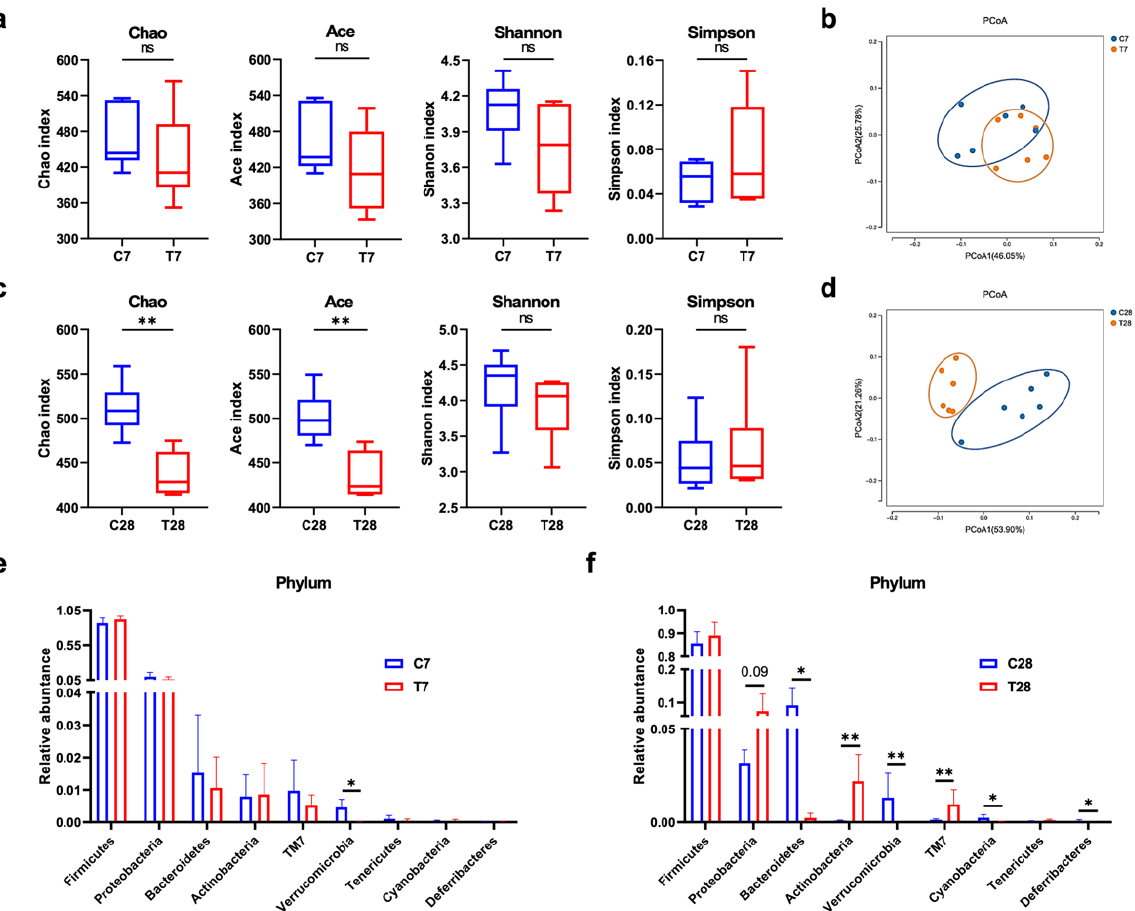
Figure 8. Compositional change of gut microbiota post-TBI. The α -diversity of the gut microbiota at 7 days ( a ) and 28 days ( b ) post-TBI ( n = 6 per group). PCoA of the gut microbiota composition with weighted UniFrac distance at 7 days ( c ) and 28 days ( d ) post-TBI ( n = 6 per group). Relative abundance of gut microbiota at the phylum level at 7 days ( e ) and 28 days ( f ) post-TBI ( n = 6 per group). Data are shown as median with range. * p < 0.05, ** p < 0.01 using Wilcoxon rank-sum test. TBI, traumatic brain injury; PCoA, principal coordinate analysis; ns, no significant.